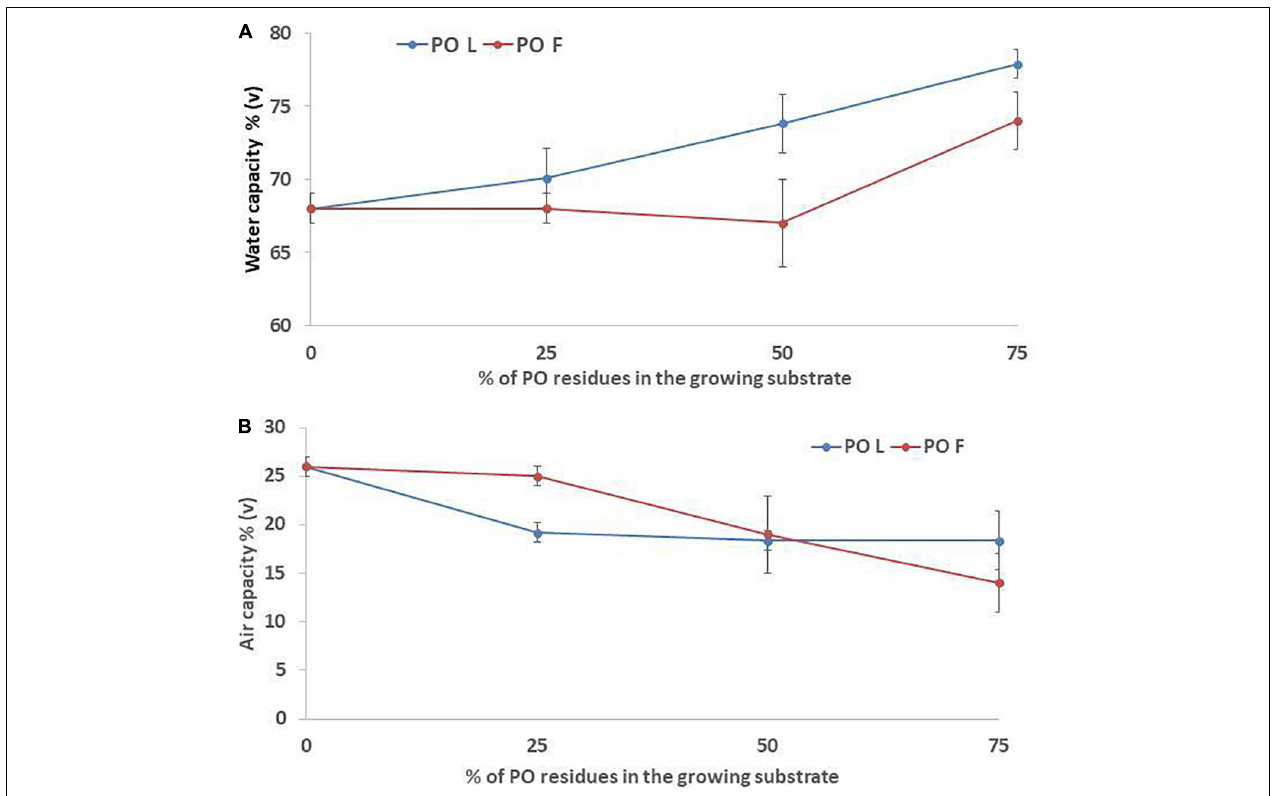
FIGURE 1 | Water (A) and air (B) capacity values of the growing media mixtures containing Posidonia oceanica (L.) Del. Residues (leaves, PO L; fibers, PO F), used for microgreens production. CTR (control 100% peat), L 25% (75% peat,25% PO L), L 50% (50% peat and 50% PO L), L 75% (25% peat and 75% PO L), F 25% (75% peat and 25% PO F), F 50% (50% peat and 50% PO F) and F 75% (25% peat and 75% PO F). Significance: ** P ≤ 0.01 (Water capacity); * P ≤ 0.05 (Air